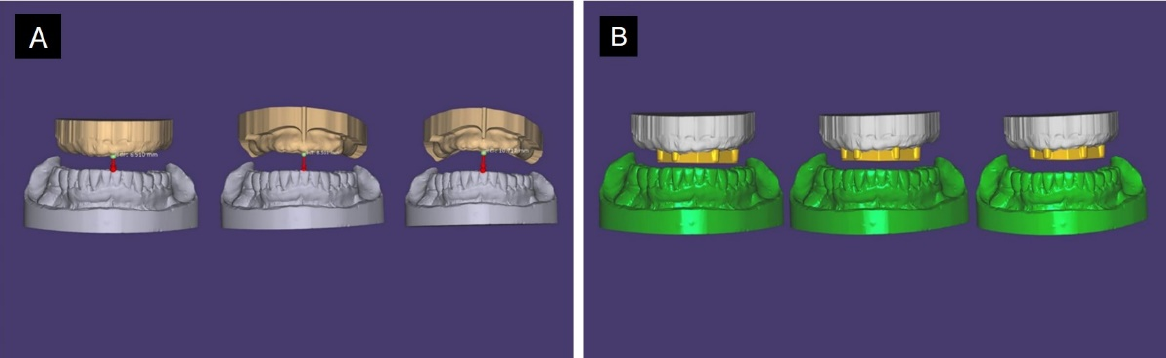
Figure 4. The jaw motion data of the old denture state implemented in Figure 2 converted into motion data in the complete edentulous arch. ( A ) Closed mouth. ( B ) Tracking movement while opening the mouth. ( C ) Extracting the maxillary and mandibular meshes of the desired height in the tracking trajectory.